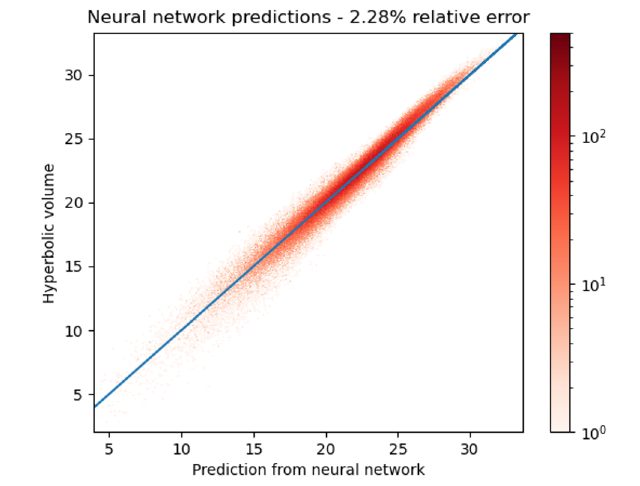
Figure 10 . Results for training the baseline neural network in Python . The network has two hidden layers, 100 neurons wide, with ReLU activation